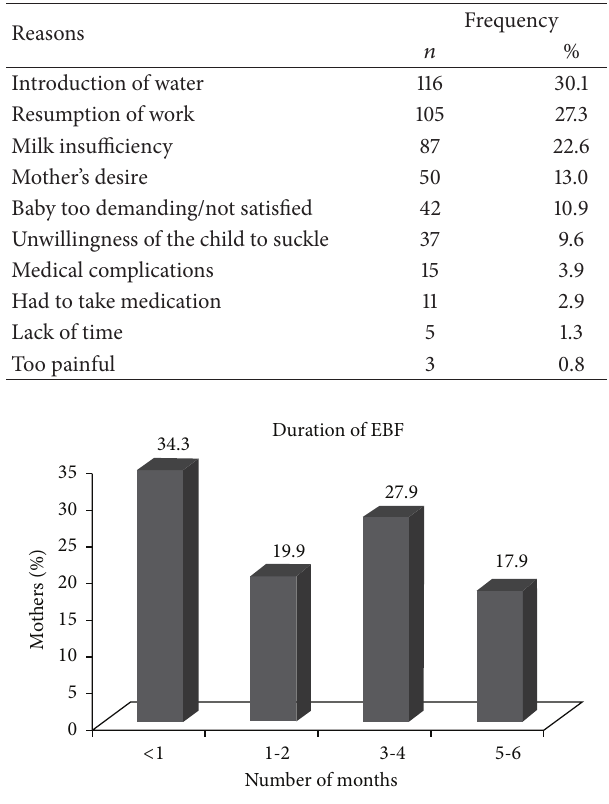
Figure 1: Duration of exclusive breastfeeding.